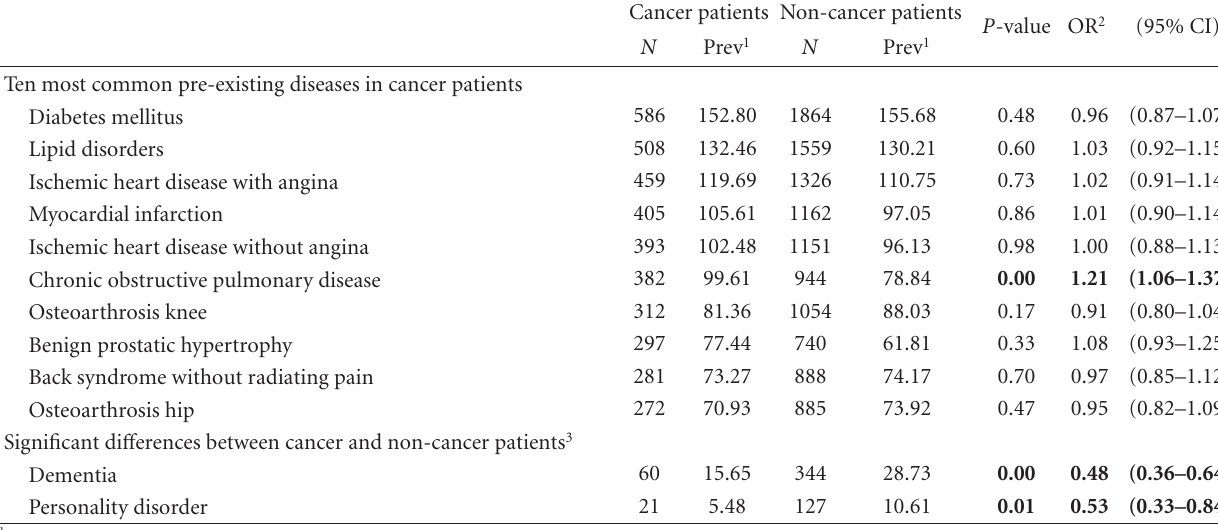
Table 2: Pre-existing chronic diseases in men and women.